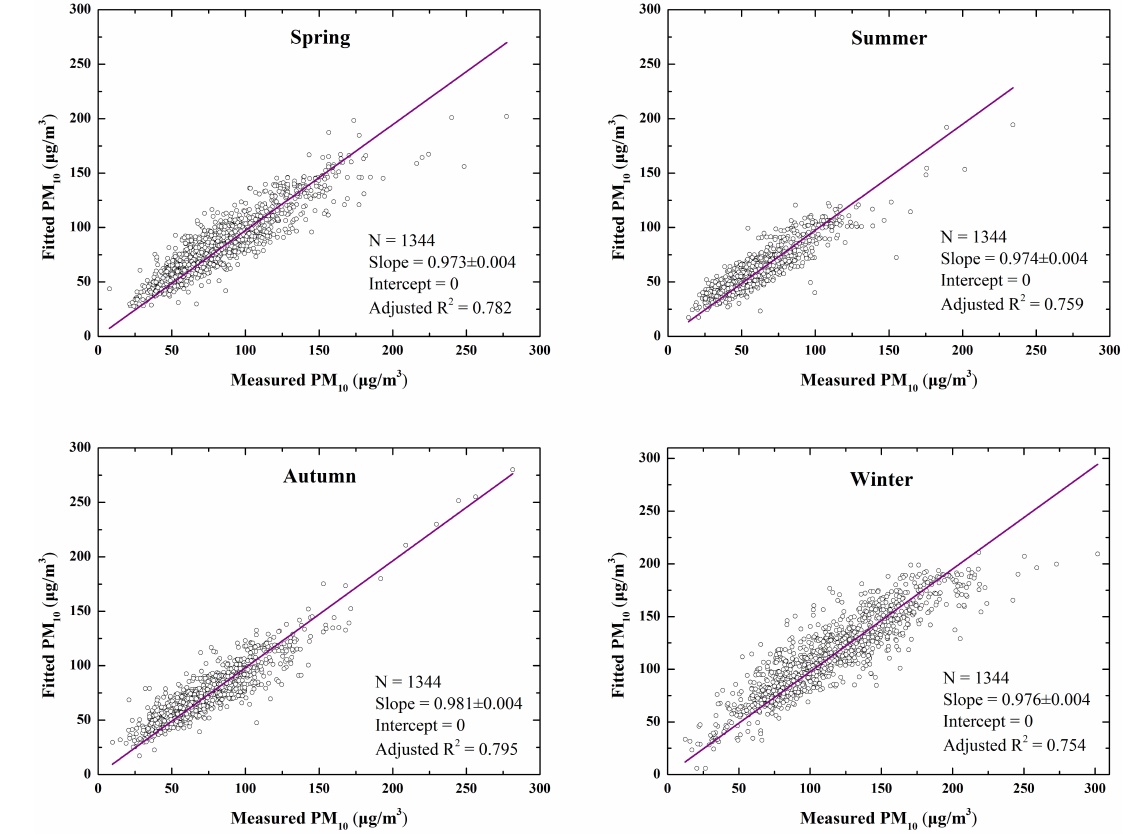
Figure 6. Comparisons of seasonal mean AOD-derived PM 10 and ground-measured PM 10 mass